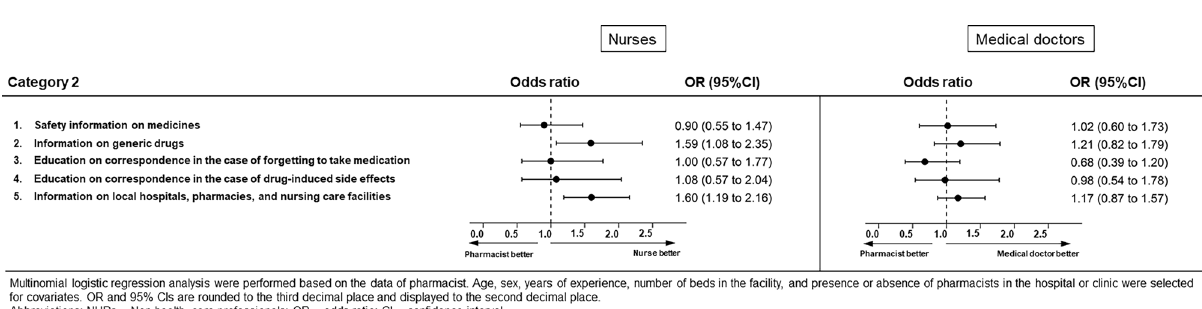
Figure 3. Results of binomial logistic regression analysis for Category 2 for non-health care professionals.